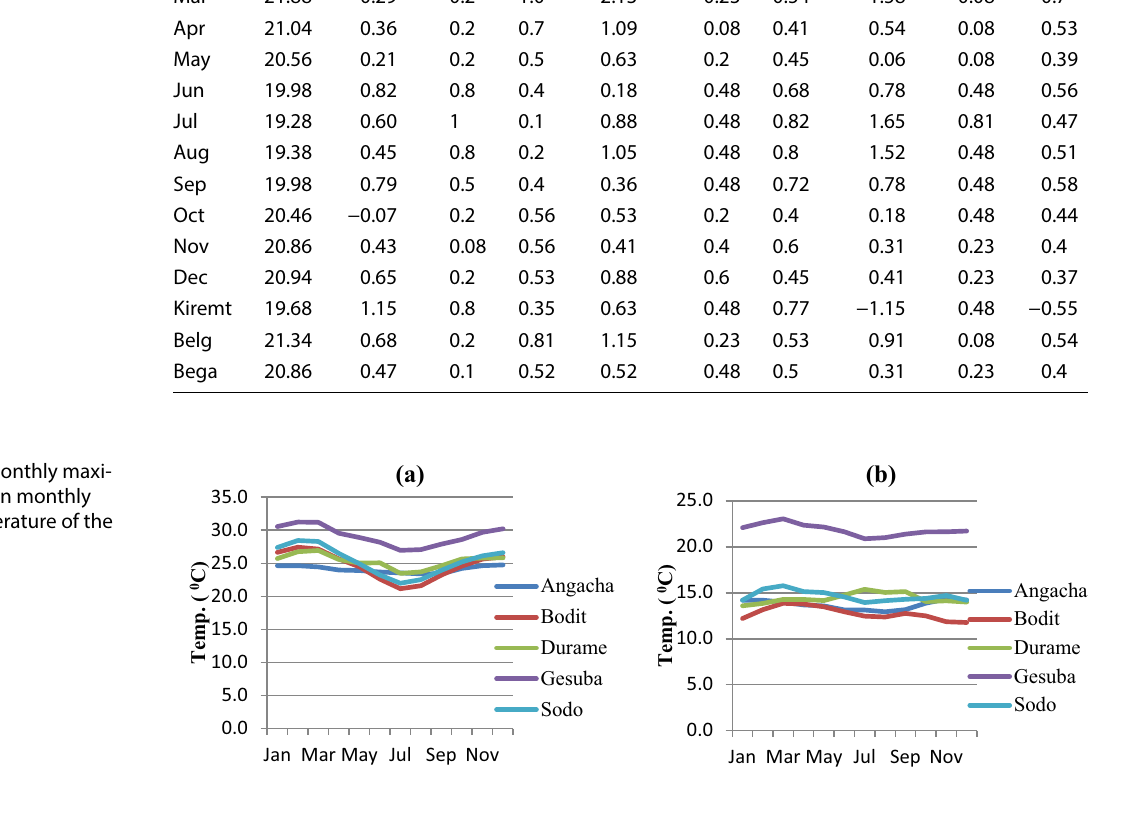
Fig. 9 Seasonal maximum, minimum and mean tempera- ture of the